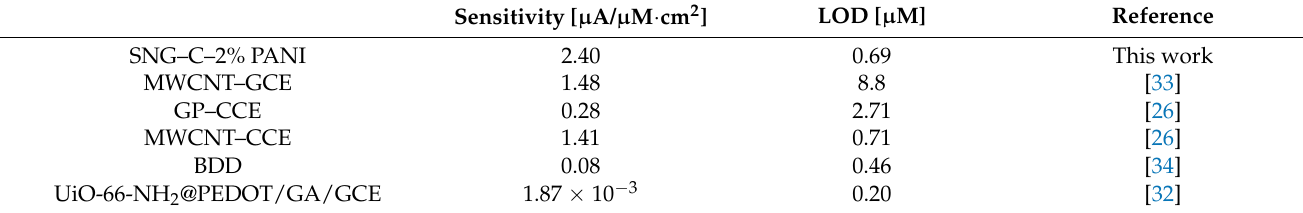
Table 1. Figures of merits for the determination of 4-chloro-3-methylphenol obtained using several electrochemical